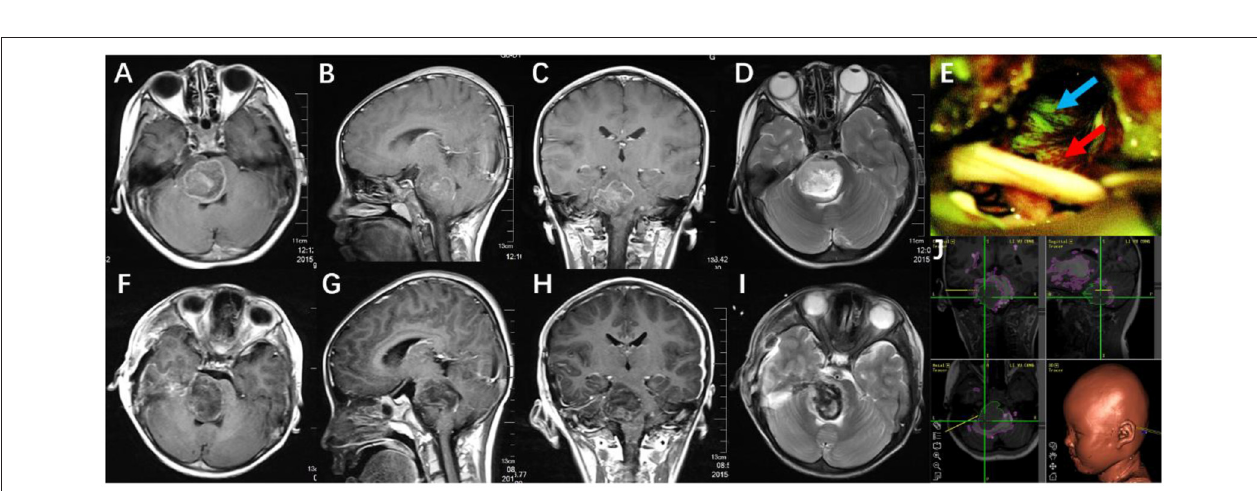
FIGURE 1 | (A–D) Preoperative MRI scan (axial, coronal, sagittal T1-weighted with gadolinium, and T2-weighted) showed adult multifocal glioblastoma. (F–I) Postoperative MRI showed complete tumor removal and relief of peritumoral edema. (E,J) During the surgery, the tumor tissue was stained yellowish green under the fluorescein mode of the microscope and was demarcated from normal brain tissue.